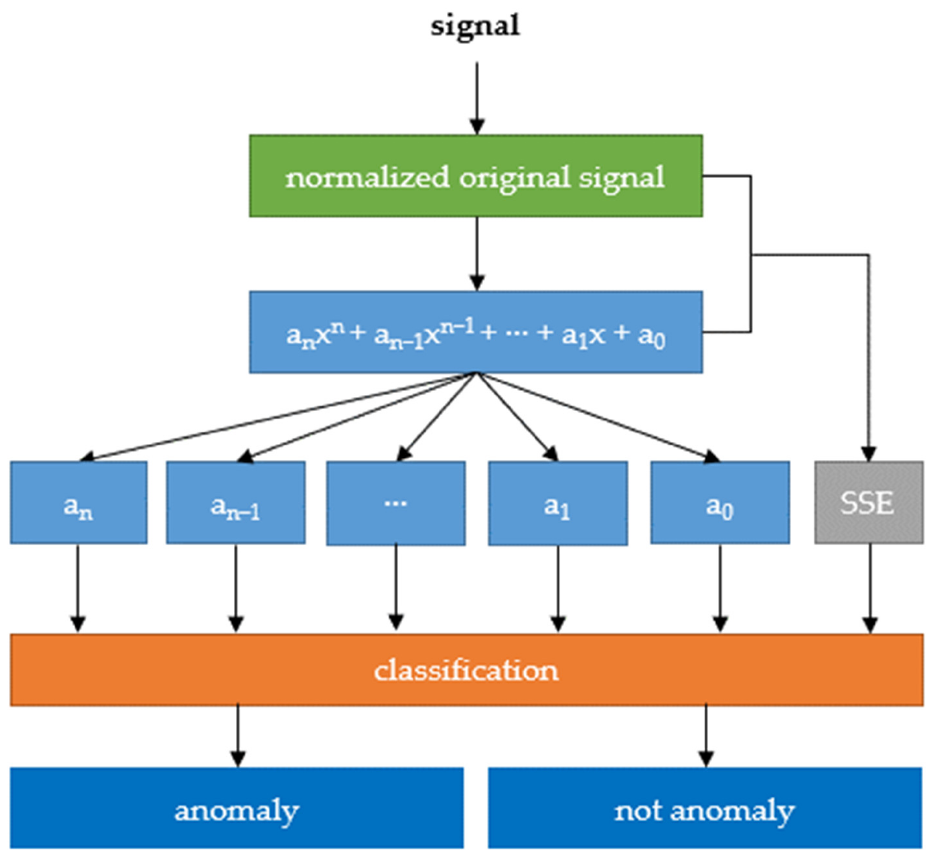
Figure 6. Schema of principle operation of the algorithm.